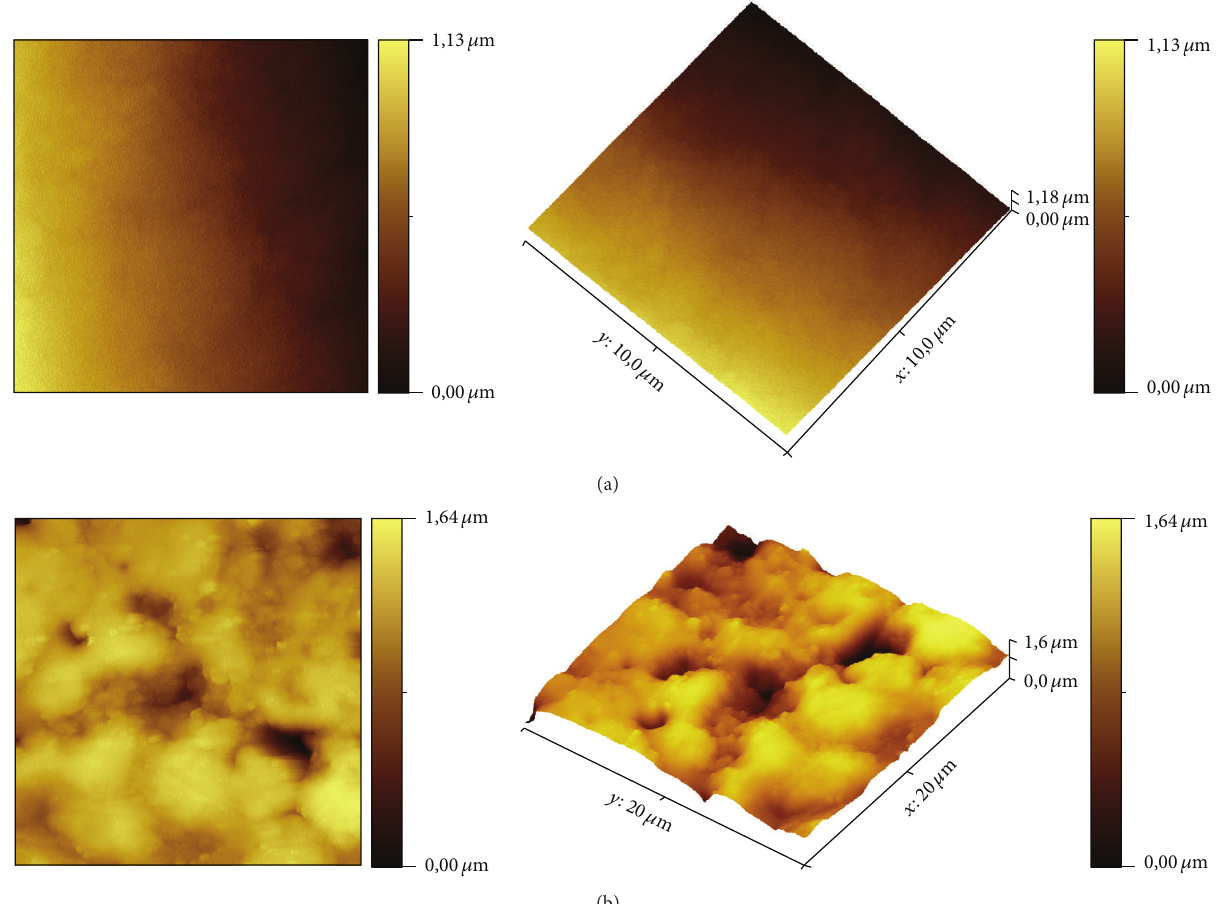
Figure10:(a)AFMtopographicimagesofunexposedPUEAF25coatingsurface.(b)AFMtopographicimageafterexposedPUEAF25coating surface in salt spray chamber.